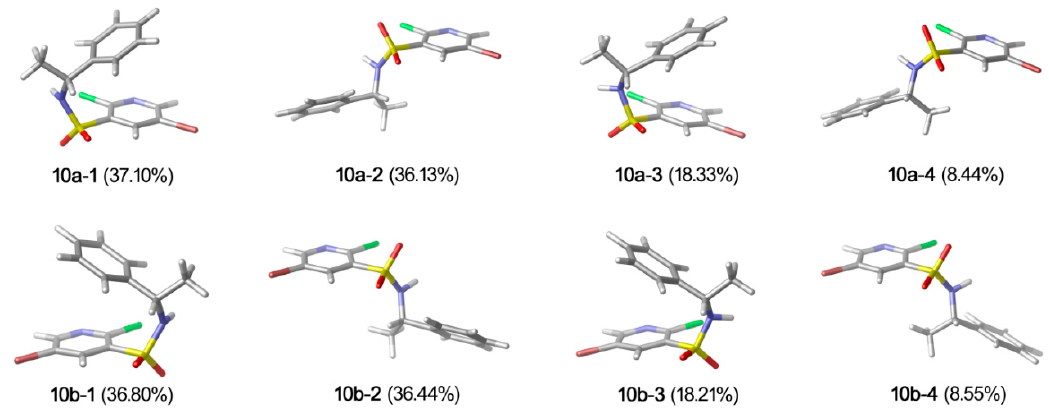
Figure 6. Relatively stable conformers of 10a and 10b .